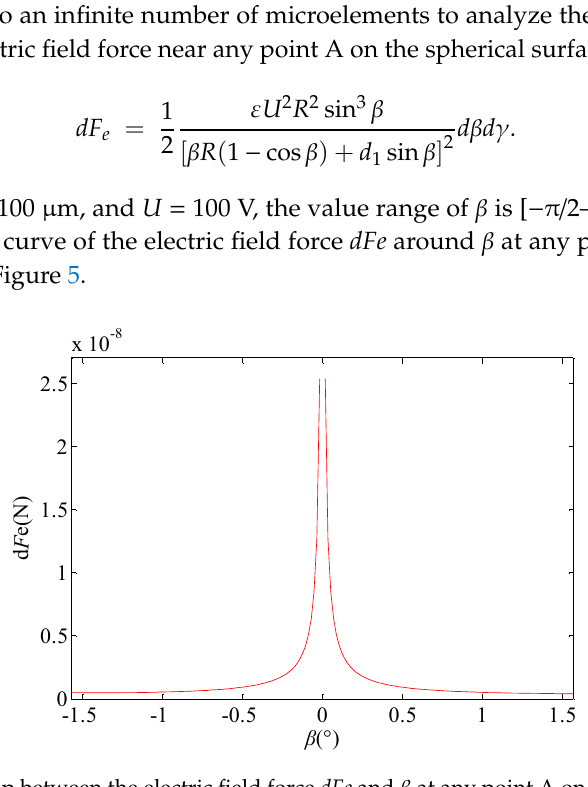
Figure 5. Relationship between the electric field force dFe and β at any point A on the spherical surface.